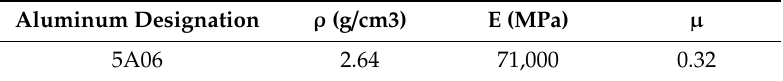
Table 1. The material parameters of the sti ff ened panel.